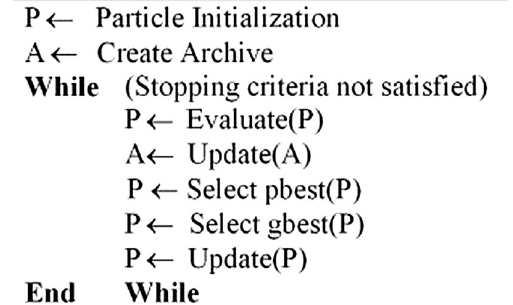
Table 16 Parameters of PSO Table 15 MOPSO